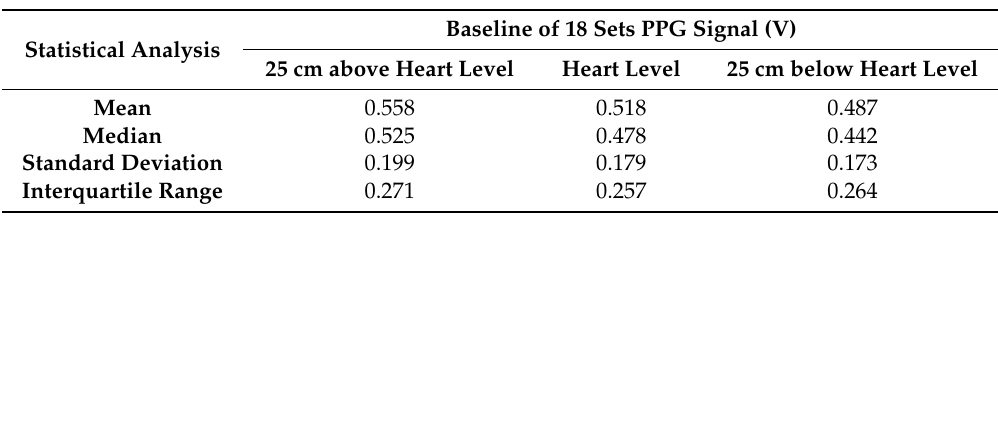
Table 3. Mean, Median, Standard Deviation, and Interquartile Range of Baseline from 18 sets of PPG signals at Different VHD Deviation.